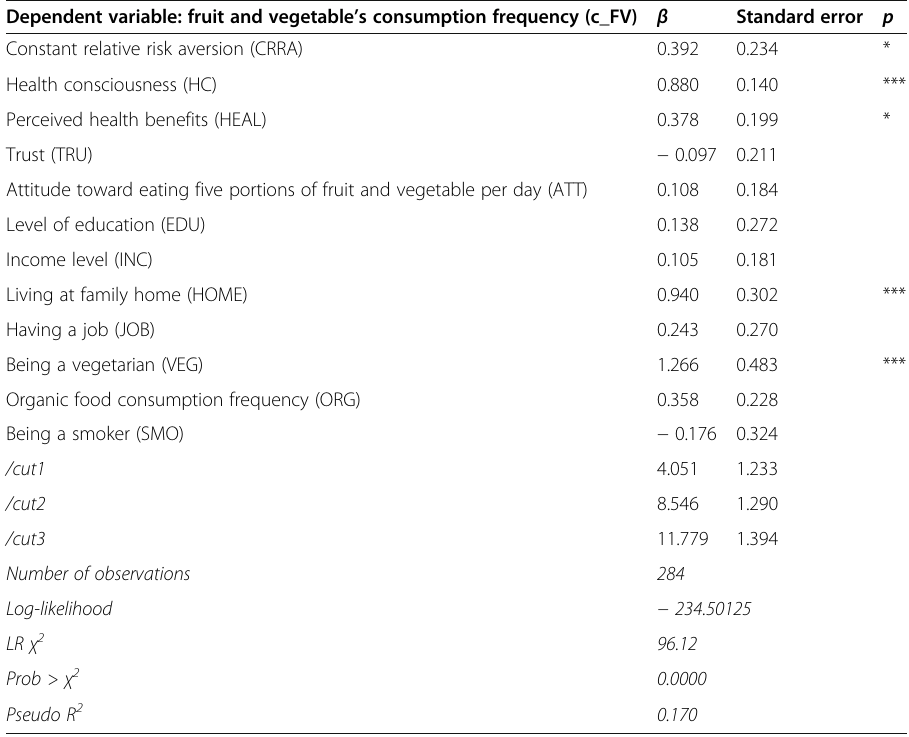
Table 6 Ordered logit estimation Dependent variable: fruit and vegetable ’ s consumption frequency (c_FV)